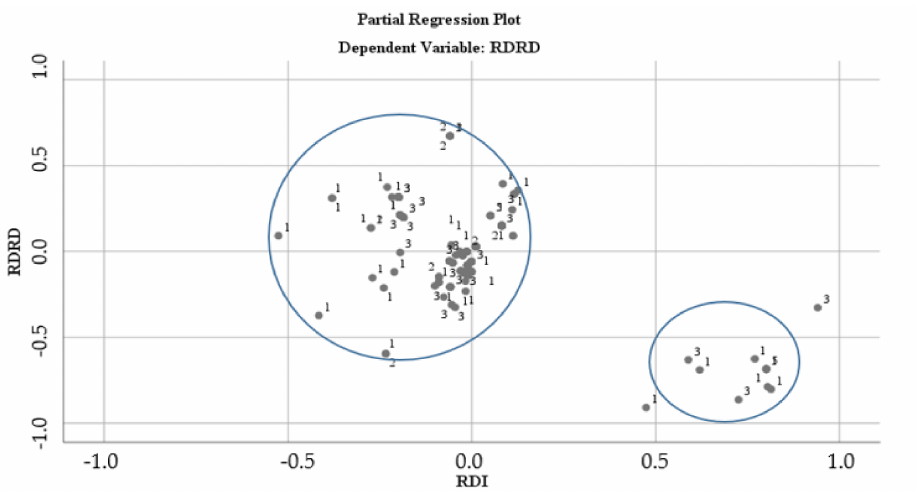
Figure 8. Regression analysis for RDI.